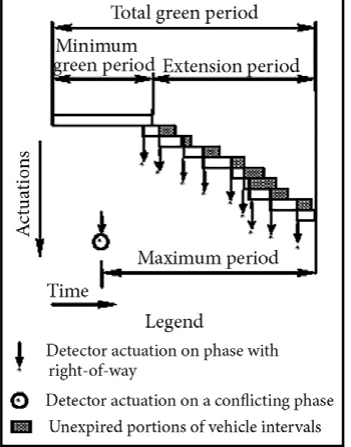
Fig. 1. Operation of an actuated